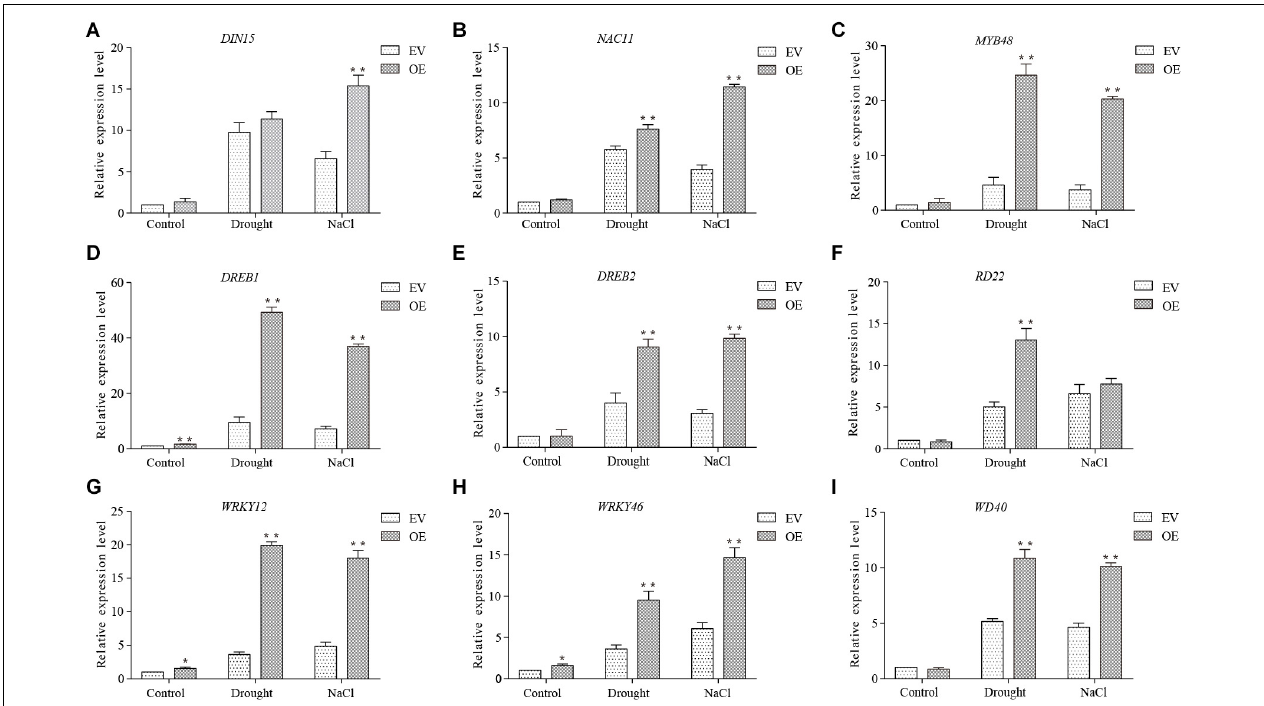
FIGURE 10 | The expression levels of stress-related marker genes DIN15 (A) , NAC11 (B) , MYB48 (C) , DREB1 (D) , DREB2 (E) , RD22 (F) , WRKY12 (G) , WRKY46 (H) , and WD40 (I) based on qRT-PCR. The actin gene is used as an internal control. Data are shown as mean ± standard deviation ( n = 3). Significant differences based on ANOVA are set at p < 0.05 (*) and p < 0.01 (**),